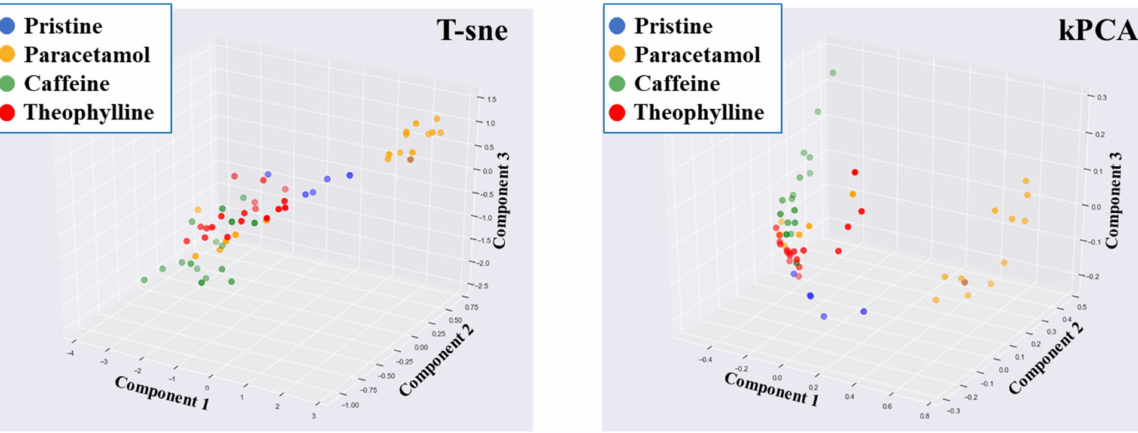
Figure 9. Non-linear transformation of the raw NIR spectra using T-sne and kPCA (kPCA1—1st principal component; kPCA2—2nd principal